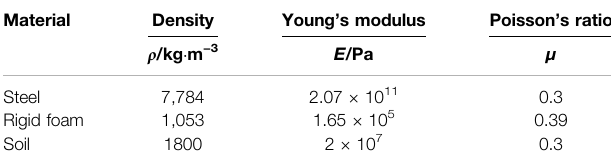
TABLE 1 | Material properties of LRSM cell and